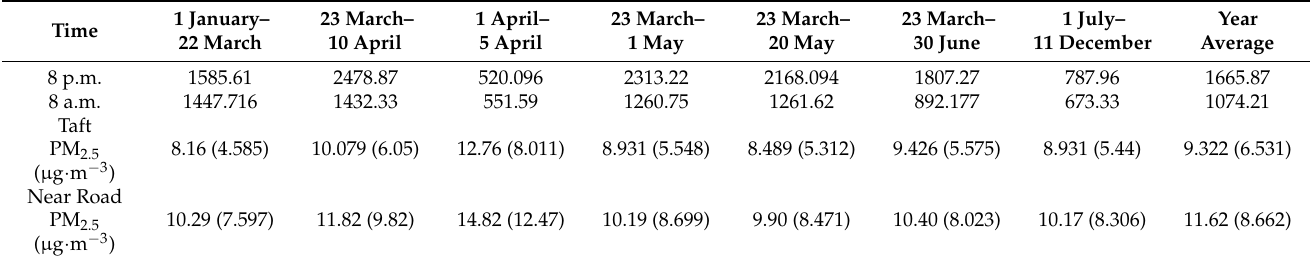
Table 2. Average ABL(m) over each indicated time period at 8 p.m. and at 8 a.m. in 2020, as well as average and standard deviation of PM 2.5 at the Near Road and Taft